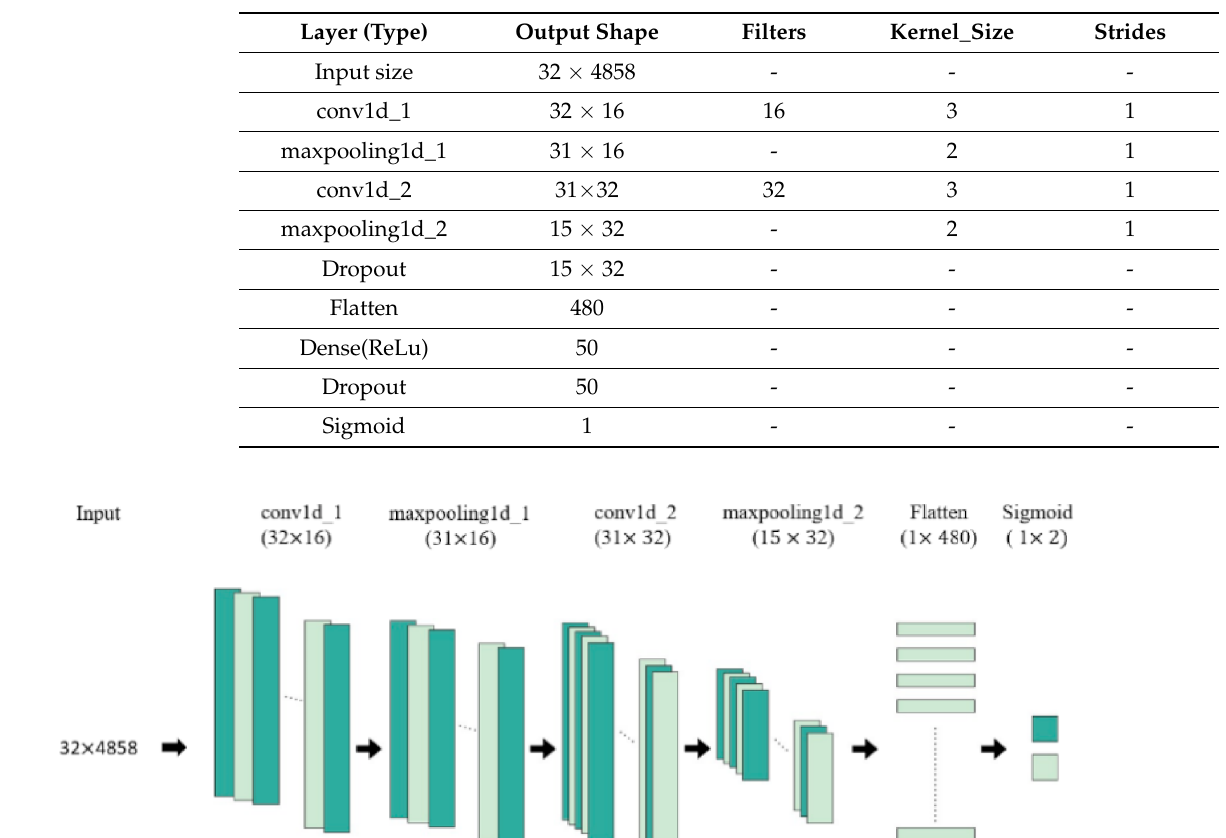
Table 3. 1DCNN model architecture (take dataset 2 as an example).